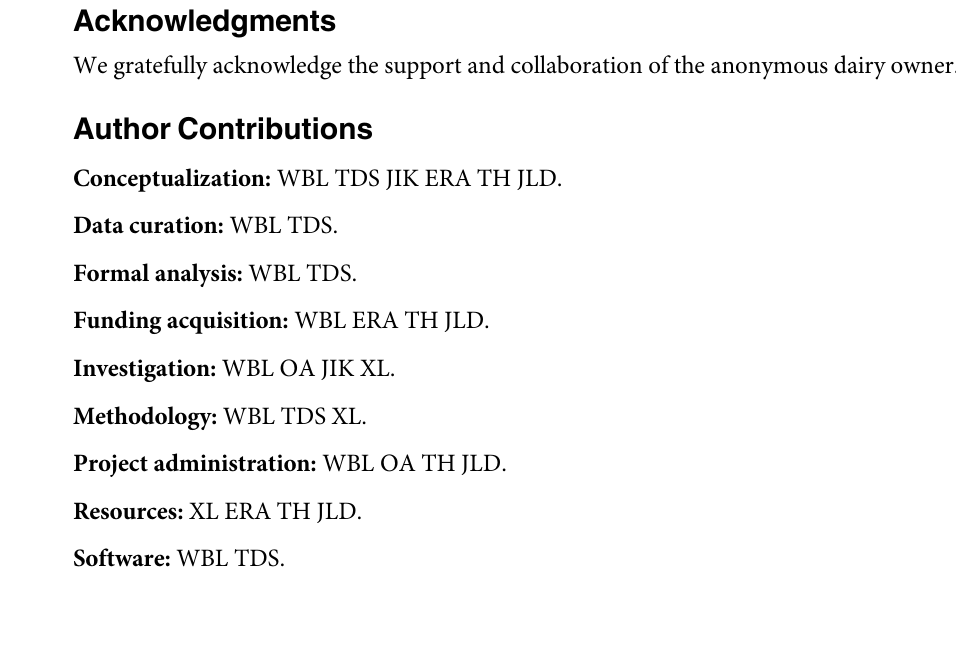
S12 Table. Total bp for FASTQ sequences for reads passing QC. S13 Table. Complete version of Table 5, including transporters. S14 Table. Water chemistry data with standard error included to supplement Table 1. S15 Table. ICP-MS data with standard error included to supplement Table 2. S16 Table. Bioinformatics software